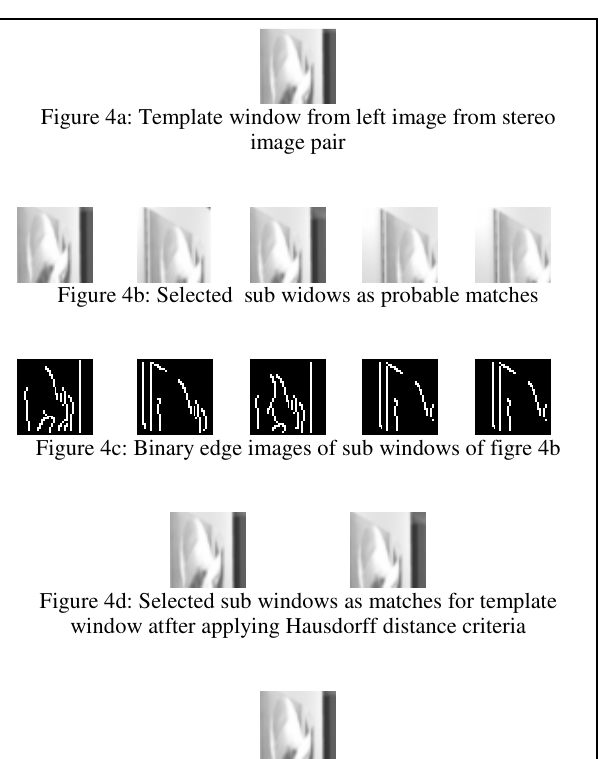
Figure 4d: Selected sub windows as matches for template window atfter applying Hausdorff distance criteria